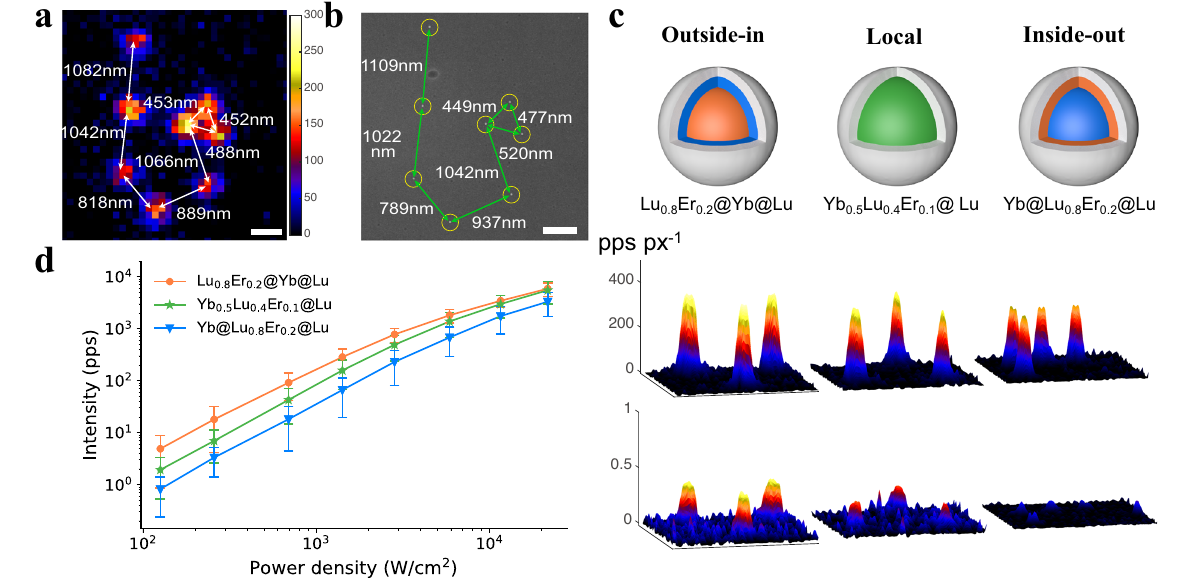
Fig. 3 | Colocalization and single-particleimaging ofoutside-in, inside-out and local energy transfer core-interior shell-inert shell UCNPs. a Wide- fi eld lumi- nescenceimageofLu 0.8 Er 0.2 @Yb@Luatapowerdensityof21.7kW = cm 2 .Scarebar, 500nm. b SEM image corresponding to the same region with respect to a Three fi eld of views were obtained for the colocalization expriments, which showed similar results. Scale bar, 500nm. c Three-dimensional representation of the wide fi eld UCL images at 21.7 kW = cm 2 (top) and 126 W = cm 2 (bottom). d Saturation